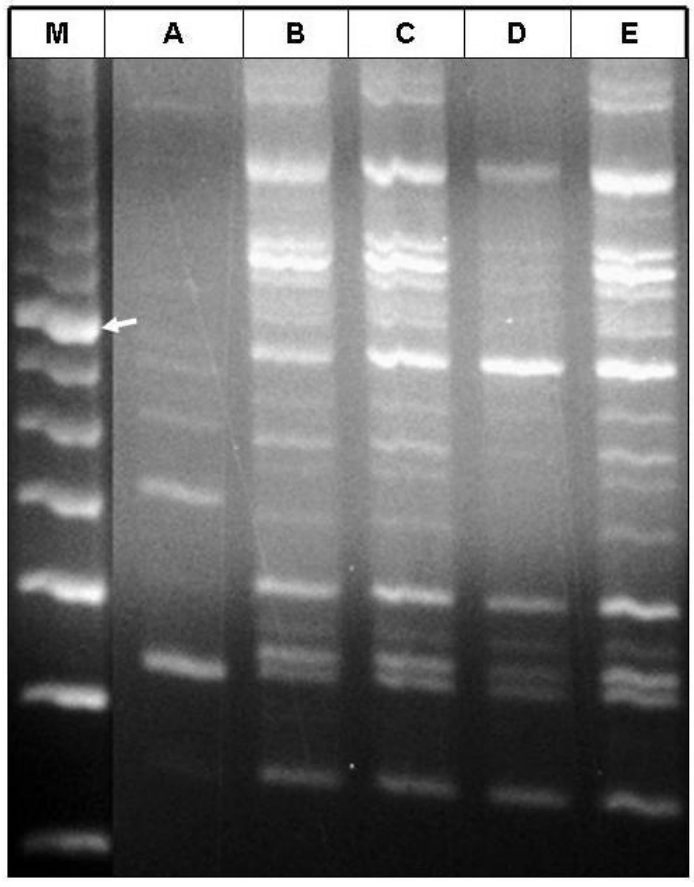
Figure 2. RAPD-PCR product profiles of extracted DNA from mature leaves of date palm using different lysis buffers. Lane M, 100 bp molecular weight marker; lanes A to E, different lysis buffers. Arrow indicates the 800 bp